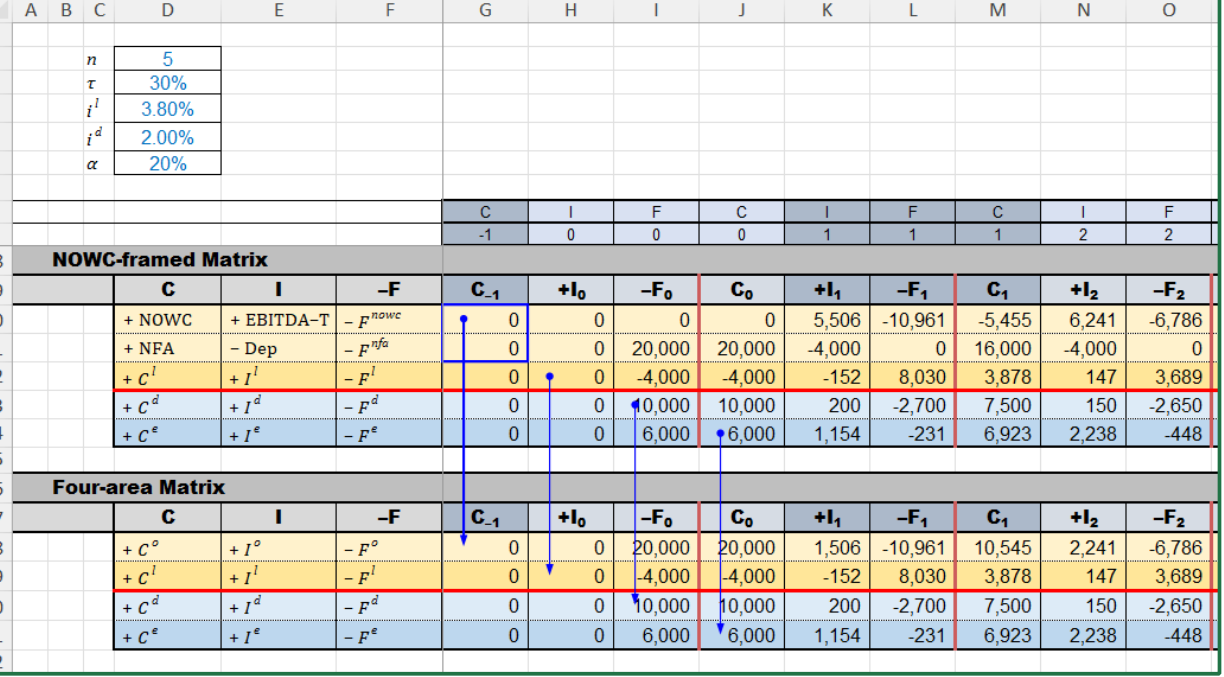
Figure 30. Four-area matrix (“SplitScreenStrip” sheet). The rows with the same color in the NOWC- framed Matrix are consolidated into one row of the same color in the Four-area Matrix. from some higher-scale matrix.